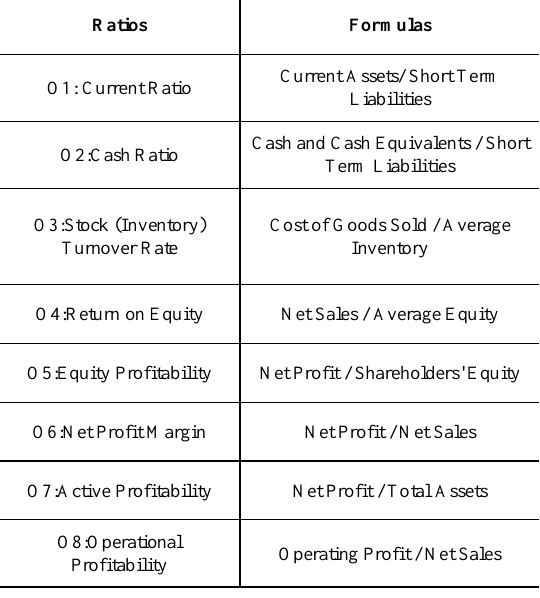
Table 3: Ratios Considered for the Research Ratios Formulas